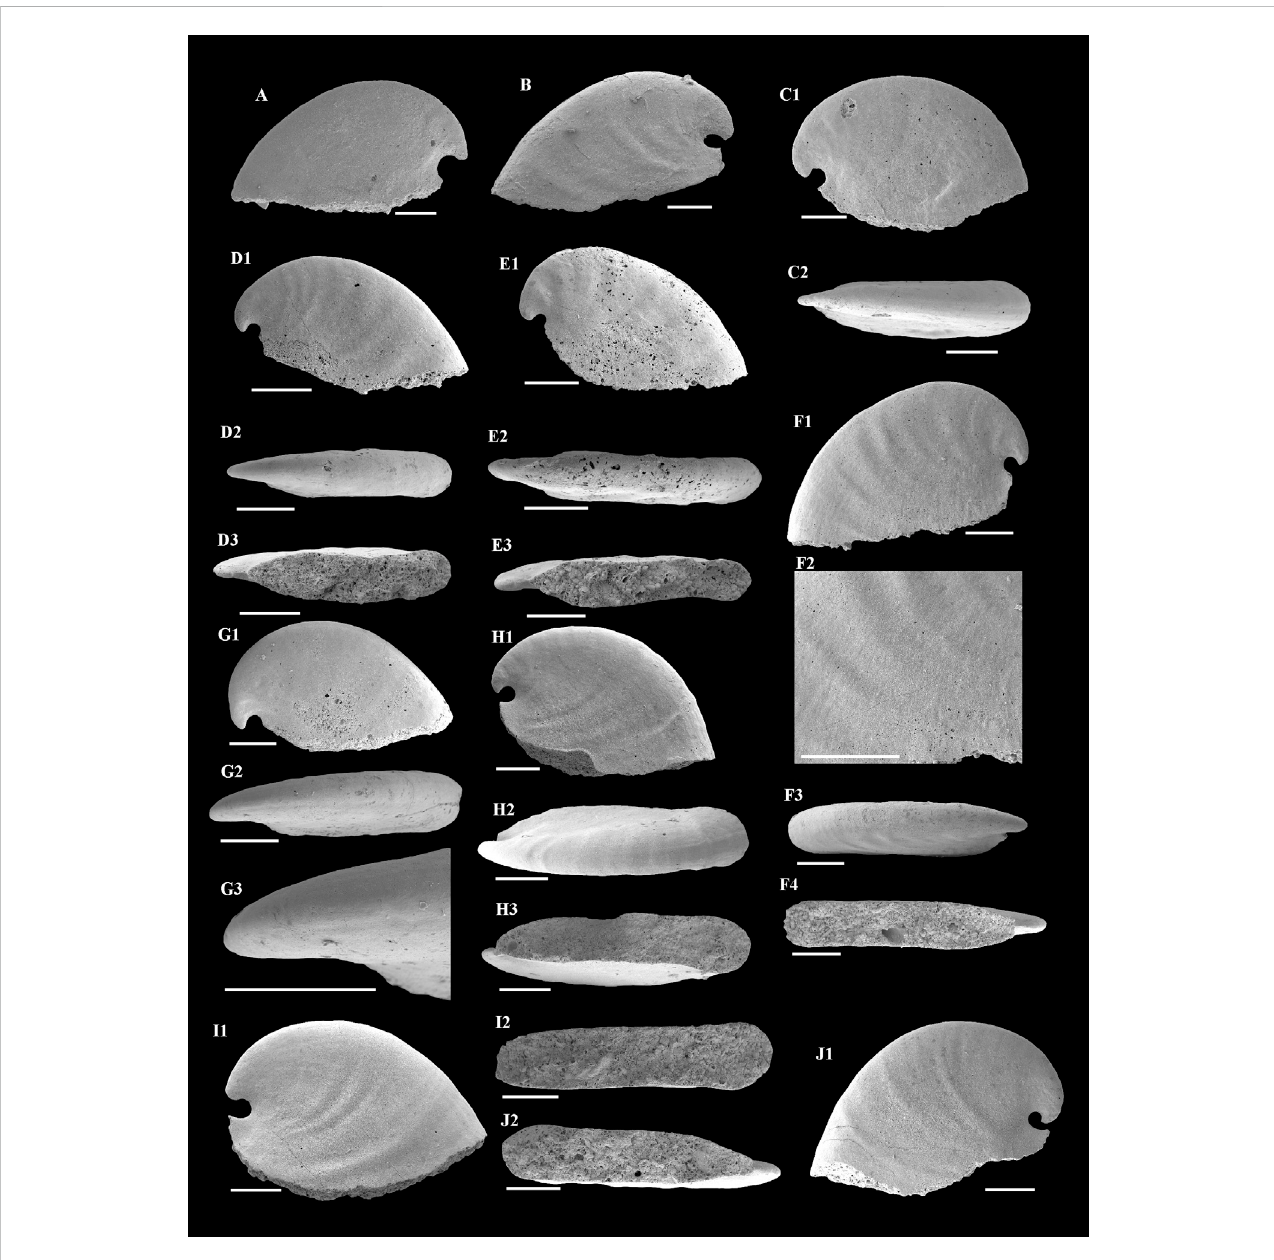
FIGURE 4 A. plana from the Member 5 of the Yanjiahe Formation. (A,B) Internal molds, lateral view, CUBar23-1, CUBar41-1. (C1) Internal mold, lateral view, CUBar235-1: (C2) dorsal view of (C1) . (D1) Internal mold, lateral view, CUBar241-2: (D2) dorsal view of (D1) , (D3) apertural view of (D1) . (E1) Internal mold, lateral view, CUBar241-3: (E2) dorsal view of (E1) , (E3) apertural view of (E1) . (F1) Internal mold, lateral view, CUBar243-2: (F2) magni fi cation of (F1) showing the faint thin ribs, (F3) dorsal view of (F1) , (F4) apertural view of (F1) . (G1) Internal mold, lateral view, CUBar241-5: (G2) dorsal view of (G1) , (G3) magni fi cationof (G2) showingtheshallowgroovesonthedorsum. (H1) Internalmold,lateralview,CUBar242-1: (H2) dorsalviewof (H1) , (H3) aperturalviewof (H1) . (I1) Internal mold, lateral view,CUBar242-2: (I2) apertural view of (I1) . (J1) Internal mold, lateral view, CUBar243-5: (J2) apertural view of (J1) . (A,B) From the Yanjiahe Section, (C1 – J1) from the Gunziao Section. Scale bars: 500 μ